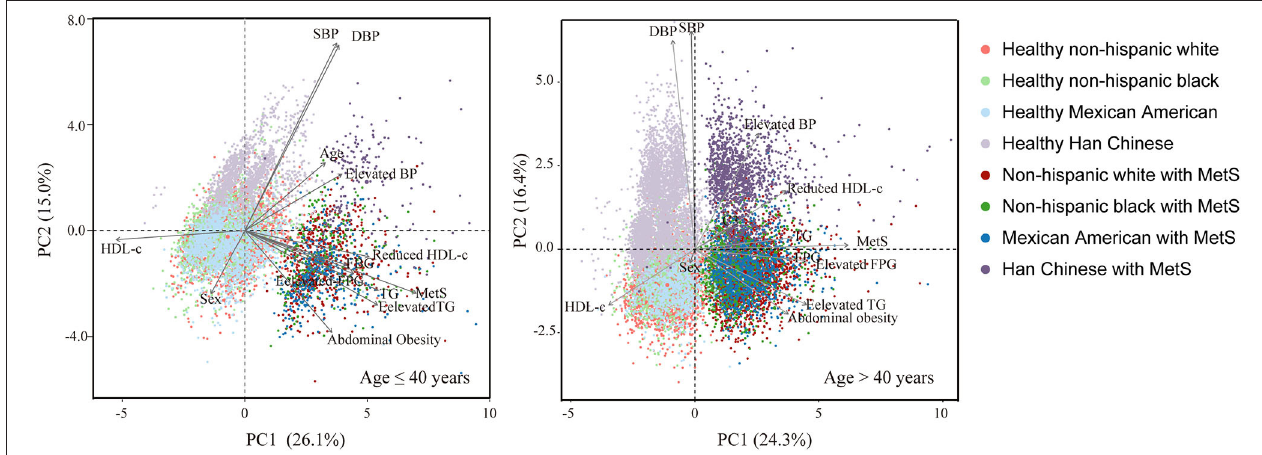
FIGURE 3 | Comparison of components of MetS between non-Hispanic whites, non-Hispanic blacks, Mexican Americans, and Han Chinese according to principal component analysis stratified by age (cut-off age = 40